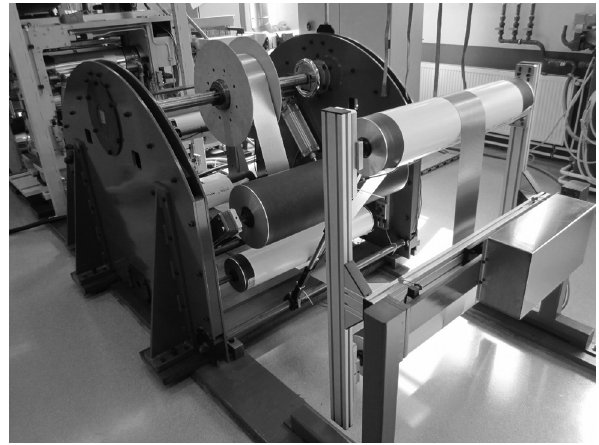
Figure 7 Detail of the assembly for roll embossing (by courtesy of Wetzel GmbH).